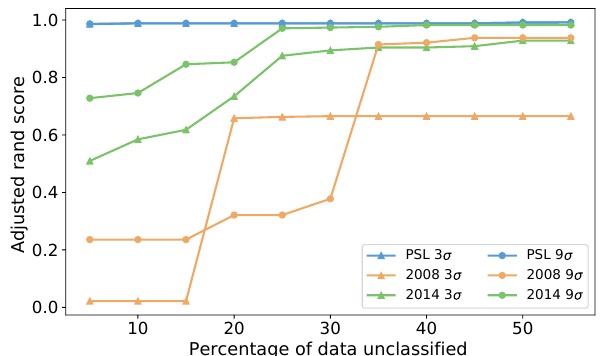
Figure 13. Adjusted rand score using different thresholds of per- centage of points we allow to be left in the analysis for DBSCAN.